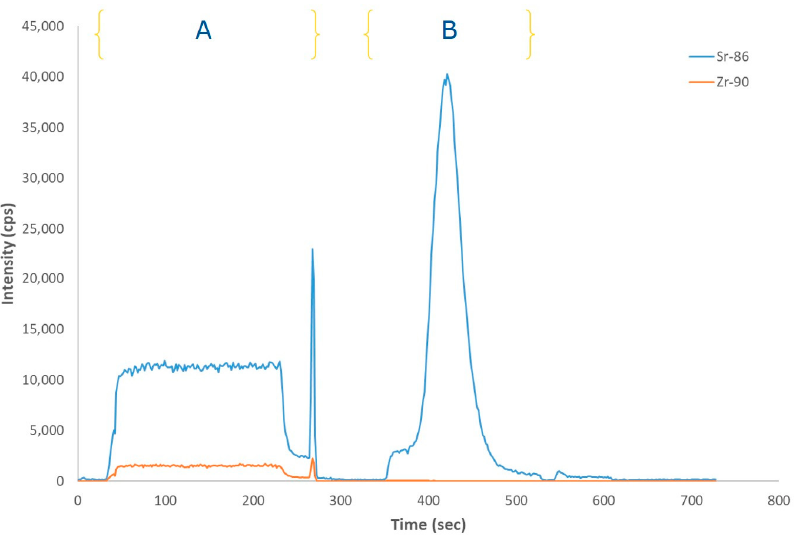
Figure 5. 86 Sr and 90 Zr profiles in direct ( A ) and pre-concentration mode ( B ). The standard working solution contains 80 pg g − 1 from an enriched standard solution of 86 Sr and 8 µg L − 1 of natural zirconium.